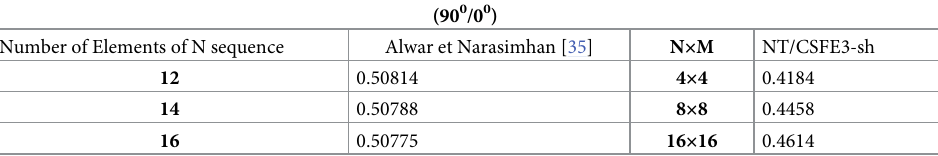
Table 7. Maximum deflection ( W 0 ) of the embedded spherical composite Laminated shell under asymmetric internal